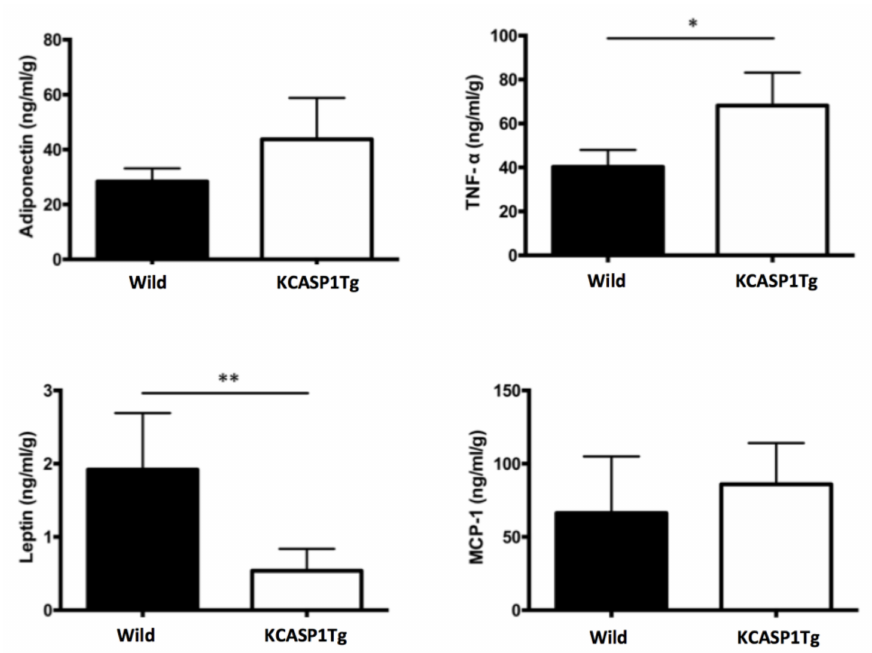
Figure 3. Adipokine expression in AT. We quantified adipocytokines such as adiponectin, TNF- α , leptin and MCP-1 from the adipocytes of GWAT by using a specific ELISA kit. The TNF- α level was elevated in KCASP1Tg mice compared to in controls; conversely, the leptin level was decreased in KCASP1Tg ( n = 5 in each group). * p < 0.05 and ** p < 0.01 versus